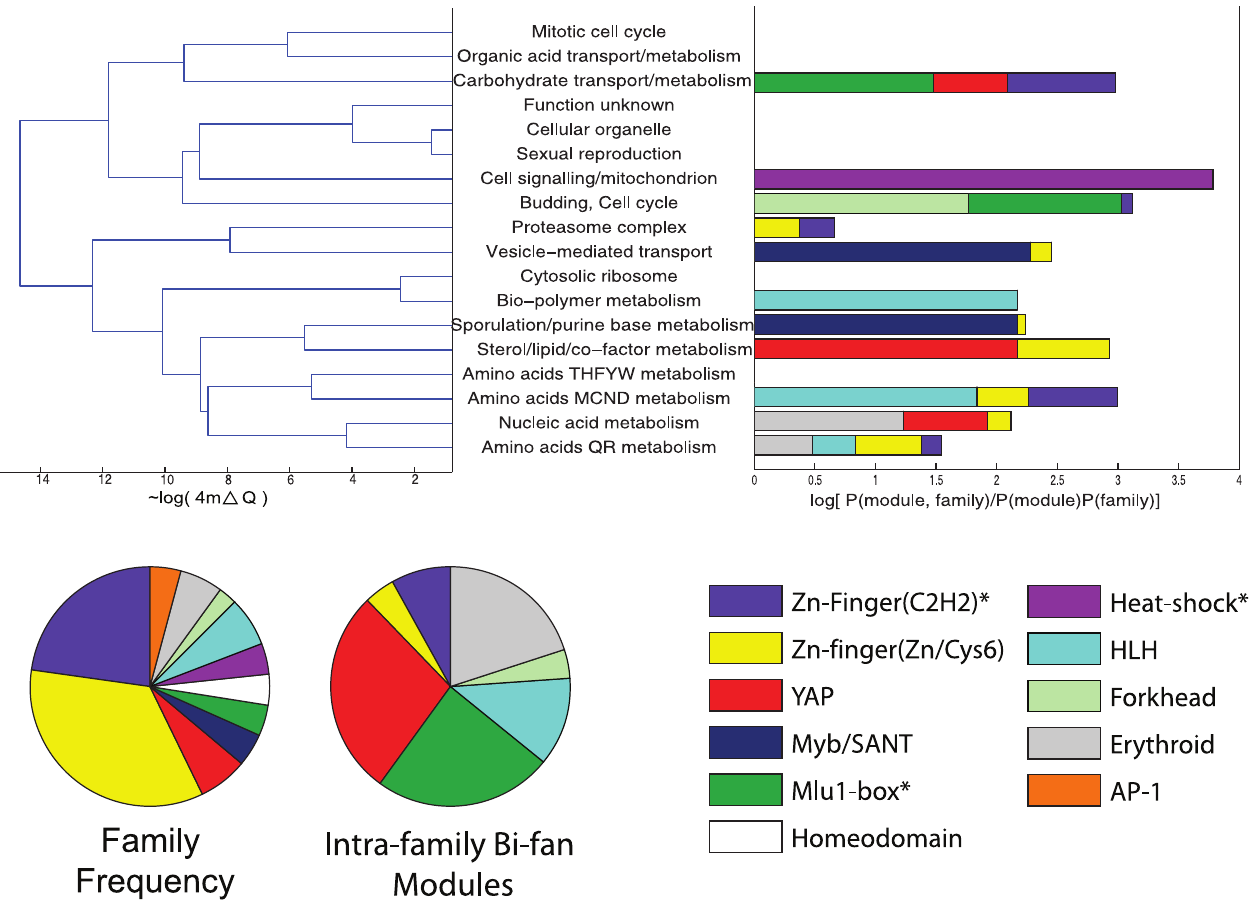
Figure 7. Tree Representation of the Division Path of the Network Clustering Algorithm, and Enrichment of TF Families within Each Module Enrichment is calculated using log-odds and includes families with more than two members in each module. The pie charts show the frequencies of the major families of transcription regulator in the Harbison et al. dataset and the number of homologous bi-fan motifs involving members of these families. Asterisks denote families that have statistically significant common module membership at the p , 0.05 level under a permutation test.